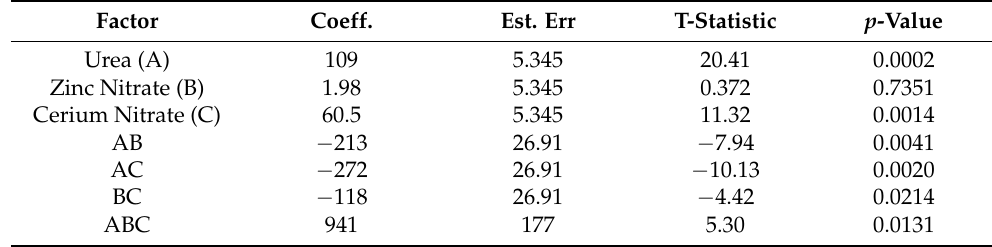
Table A4. Student’s test to evaluate the coefficients of the cubic model describing the surface